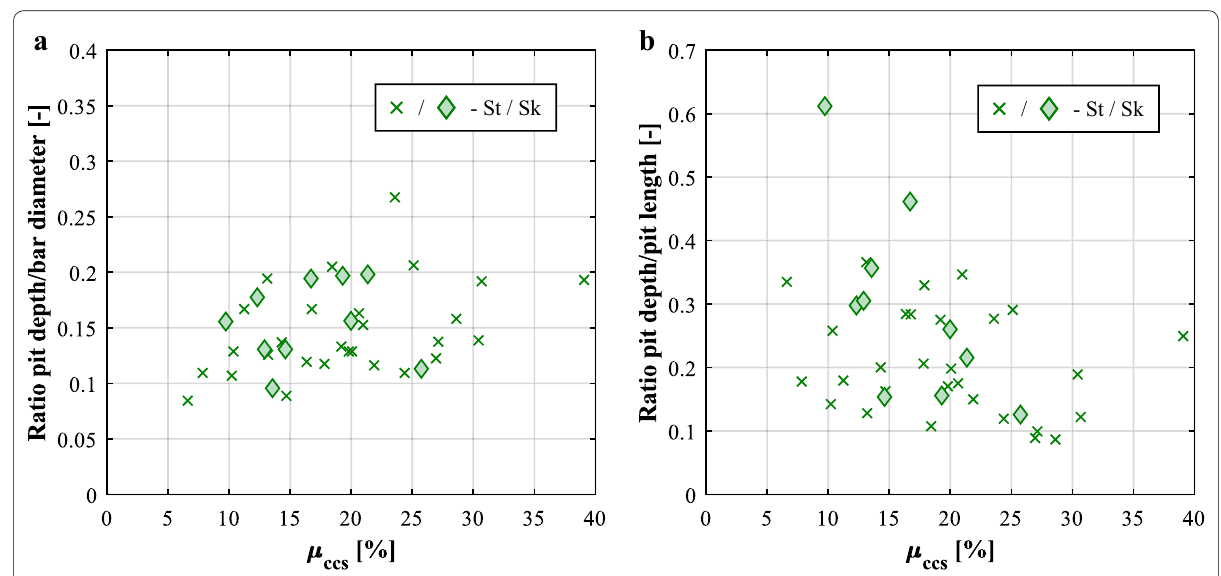
Fig. 14 Pit depth ratios as a function of the critical corrosion level: a to nominal diameter and b to pit length.